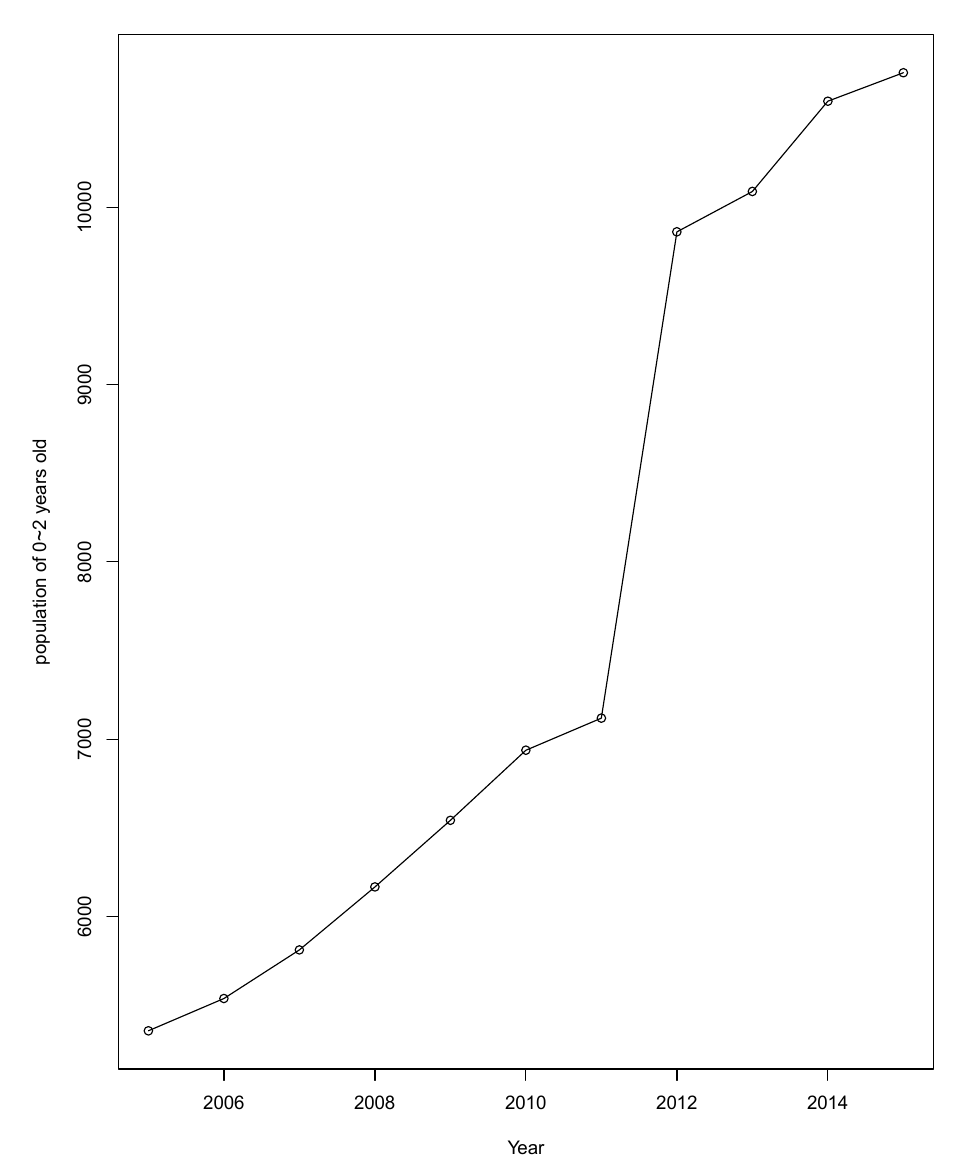
Figure A2. Population aged 0 to 3 in Jiashi County during 2005–2015. Table A1. Percent change of VL events associated per unit increase of land surface maximum temperature and precipitation.